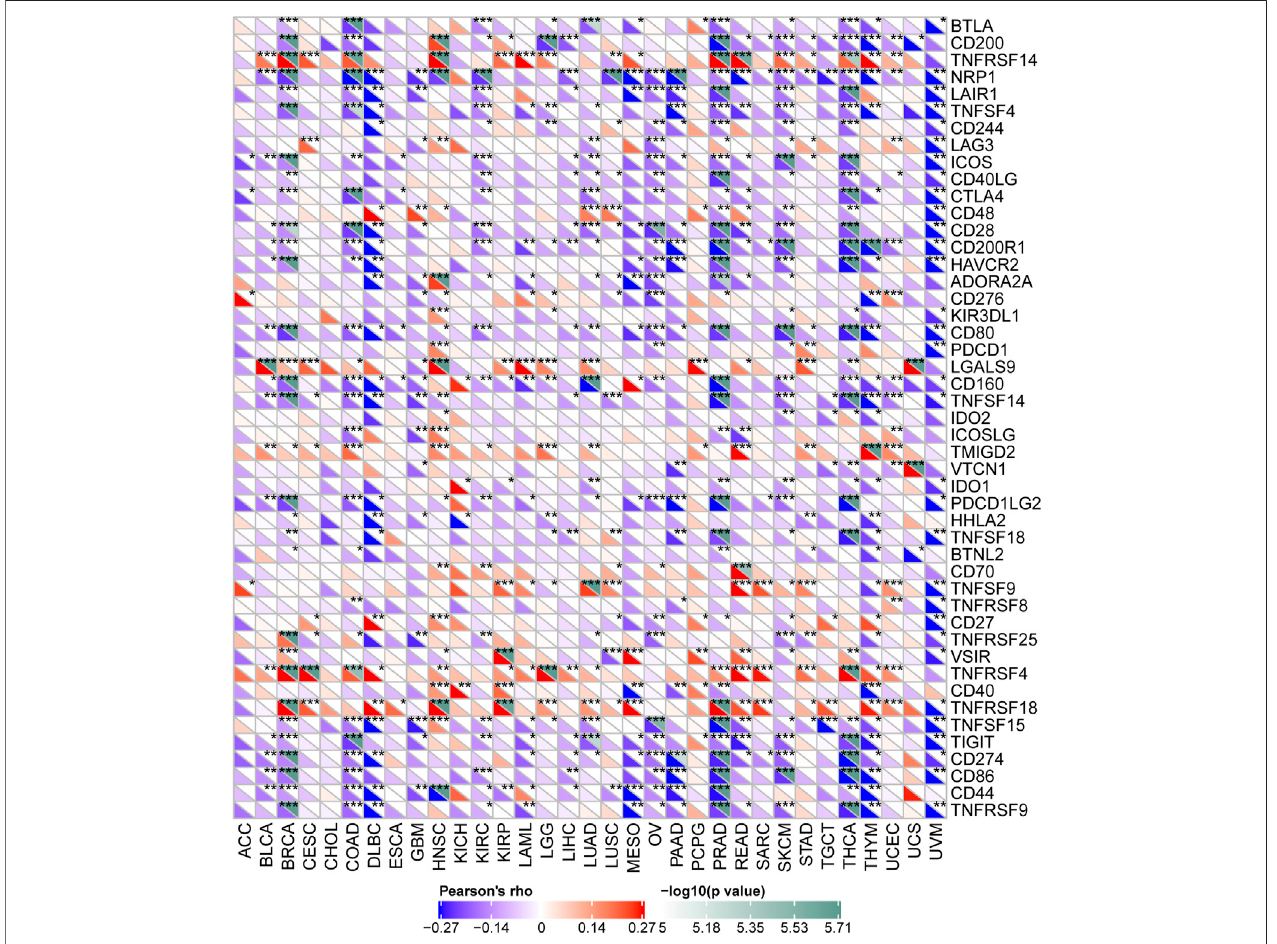
FIGURE8| CorrelationsbetweentheexpressionofALKBH7andimmunecheckpointgenesin33typesofcancer. “ * ” indicates p < 0.05, “ ** ” indicates p < 0.01and “ *** ” indicates p < 0.001.